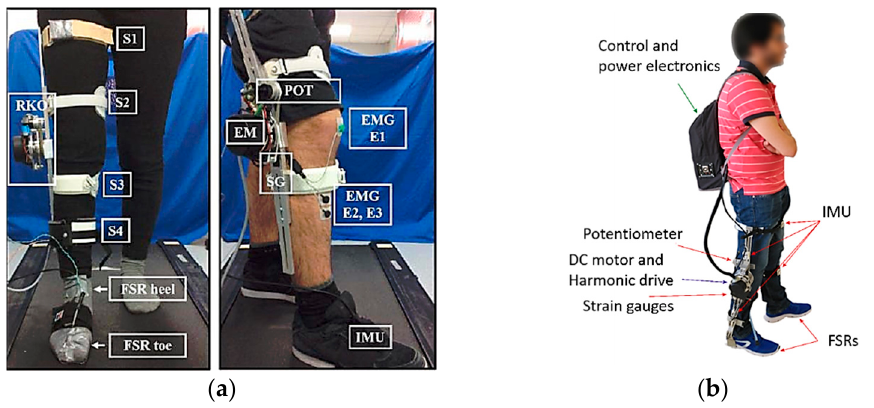
Figure 12. Knee orthosis system: ( a ) Félix et al., 2017 [73] y ( b ) Lora et al., 2018 [26].